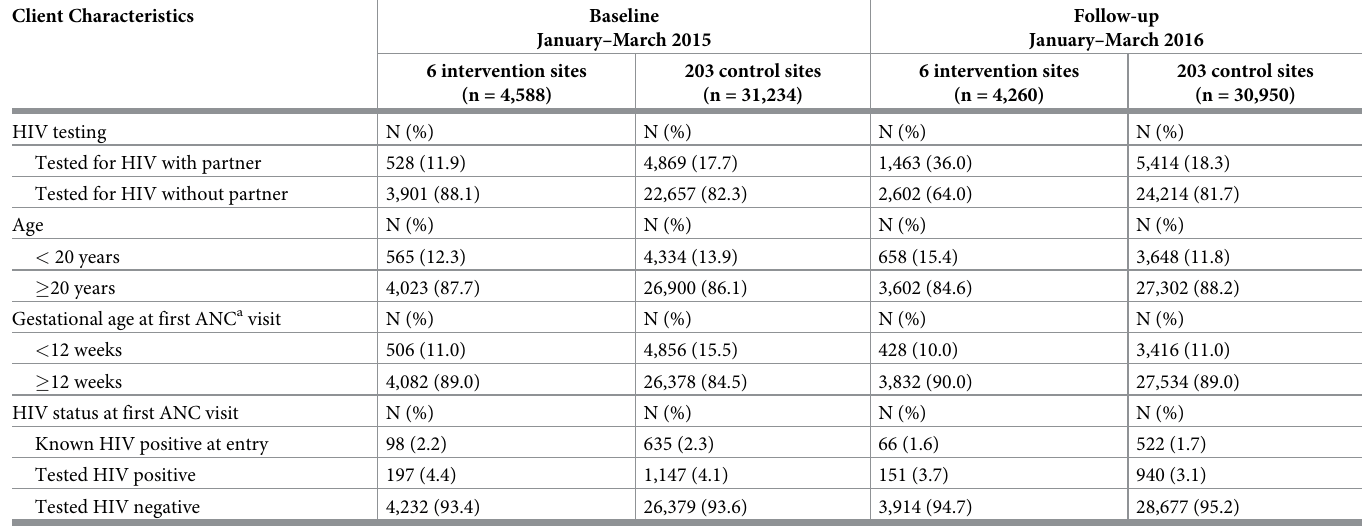
Table 1. Characteristics of pregnant women who registered for antenatal services at 209 health facilities in Dar es Salaam at baseline (January–March 2015), prior to the male partner intervention, and follow-up (January–March 2016). Client